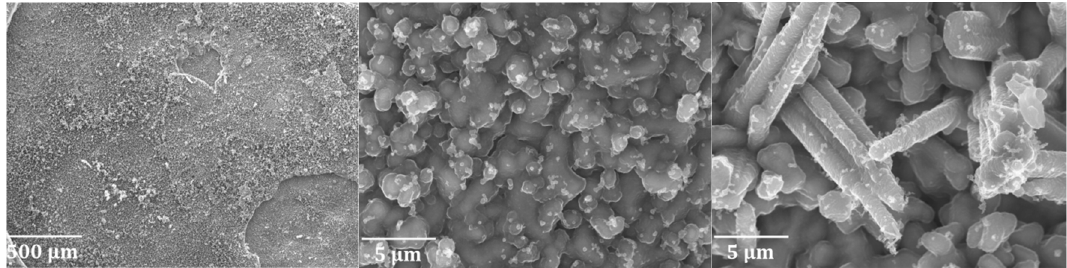
Figure 5. Surface of a decoked Ti–base alloy after pretreatment B and two coking/decoking cycles at an accelerating voltage of 20 kV.